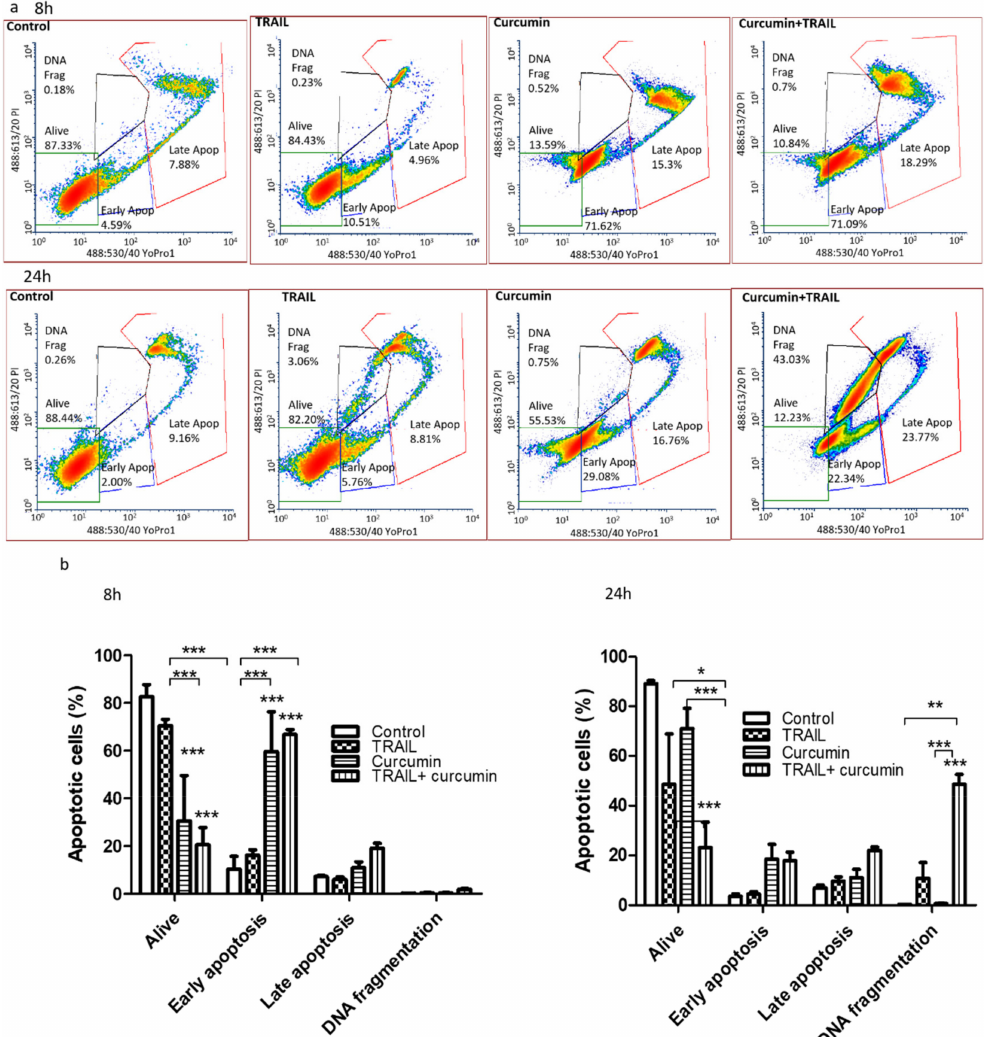
Figure 4. Curcumin or curcumin + TRAIL induced apoptotic cell death. ACHN cells were cultured on six-well plates and exposed to 25 µ M curcumin for 4 h. Following this, the cells were incubated with 0.05% DMSO in culture medium or 50 ng / mL TRAIL for 8 or 24 h ( a ). The treated cells were labelled with YO-PRO-1 (100 µ M in DMSO) and propidium iodide (10 µ g / mL) immediately prior to flow cytometry analysis. ( a ) Representative scatter plots show and compare the e ff ects of the treatments at two di ff erent time points (8 and 24 h). ( b ) Results are presented as the mean of the percentage of early apoptosis, late apoptosis, and DNA fragmented cells induced by a specific treatment ± SEM of three independent experiments. *, ** and *** indicate statistically significant di ff erence from respective control at p < 0.05, p < 0.01, and p < 0.001, respectively. Two-way ANOVA was used to analyse the